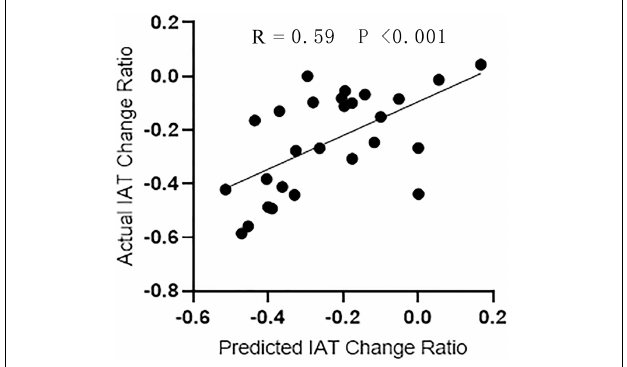
FIGURE 5 | The regression performance of SVR model. Correlation analysis between the actual IAT change ratio and the predictive change ratio predicted by